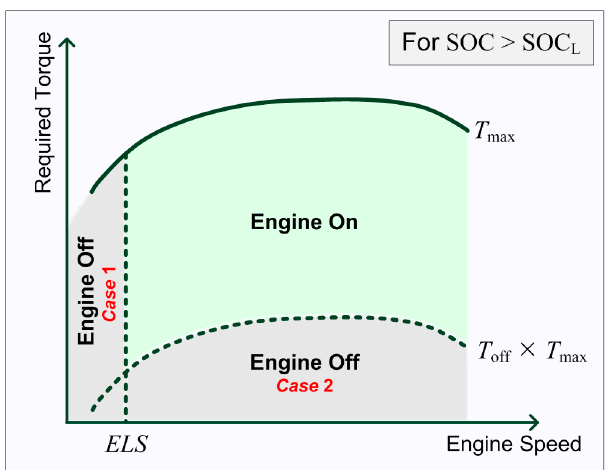
Figure 3. Electric assist control strategy (EACS) for high state of charge (SOC). Figure 4. Electric assist control strategy (EACS) for high state of charge (SOC).